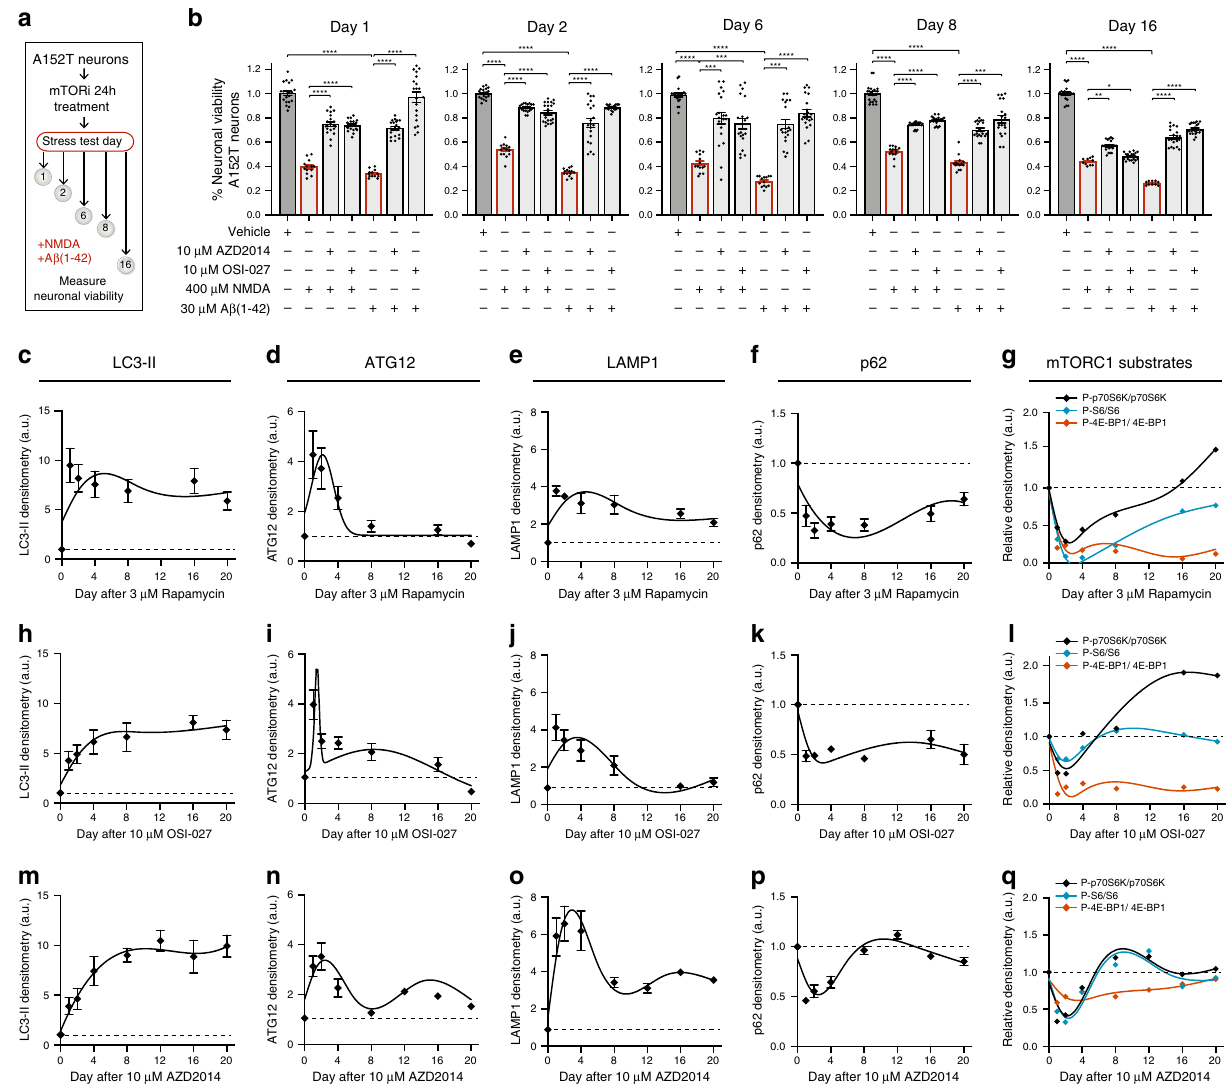
Fig. 8 Time-course analysis of mTORi effect on neuronal vulnerability to stress, autophagy and mTORC1 activity. a Assay to measure mTORi time- course effect on neuronal vulnerability to stress. A152T neurons (FTD19-L5-RC6, 6 weeks differentiated) were treated with 10 μ M AZD2014 or OSI-027 for 24 h (day 0 – 1), followed by media change. Then, on each day indicated, neurons were stressed with either 400 μ M NMDA or 30 μ M A β (1-42) for 18 h, and viability was measured. b Graph bars represent mean % viability, relative to vehicle ± SEM and diamond dots represent individual data points for n = 3 (and 4 technical replicates per experiment). Statistical signi fi cance was calculated with a two-tailed unpaired t -test (* P ≤ 0.05, ** P ≤ 0.01, *** P ≤ 0.001, **** P ≤ 0.0001). c – q Neurons were treated with 3 μ M rapamycin ( c – g ), 10 μ M OSI027 ( h – l ) or 10 μ M AZD2014 ( m – q ) and analyzed by western blot over a period of 20 days (Supplementary Fig. 9a, b). c – f , h – k , m – p Time-course densitometry of LC3-II, ATG12, LAMP1 and p62 autophagy protein levels. Data points represent mean densitometry, relative to vehicle-treated samples (dotted lines) ± SEM for n = 3 biological replicates. g , l , q Time-course measure of mTORC1 substrates ’ phosphorylation (p70S6K, S6, 4E-BP1). Data points represent mean densitometry, relative to vehicle-treated samples (dotted lines) for n = 2 biological replicates. Source data are provided as a Source Data fi